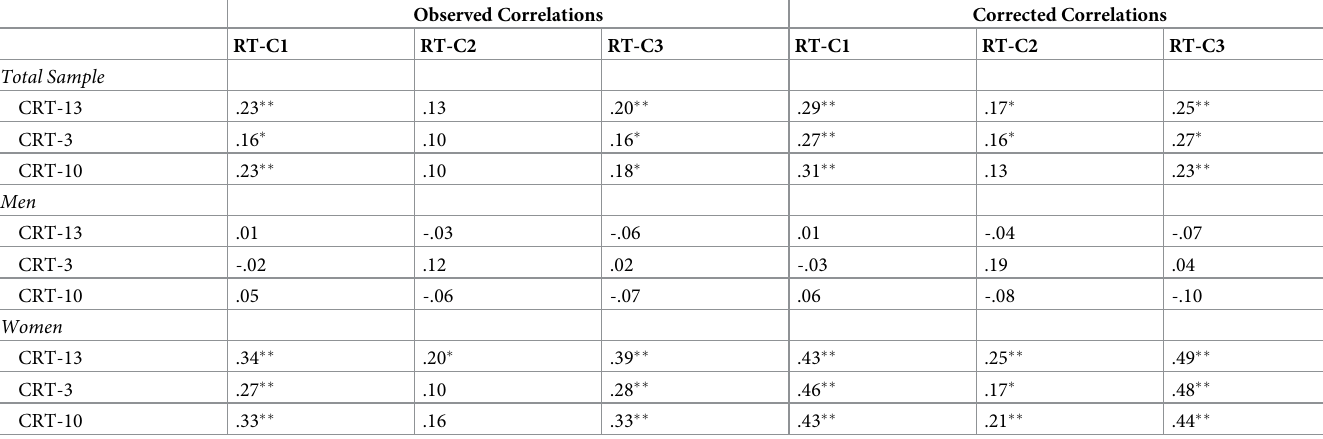
Table 7. Correlations between CRT scores and response time.